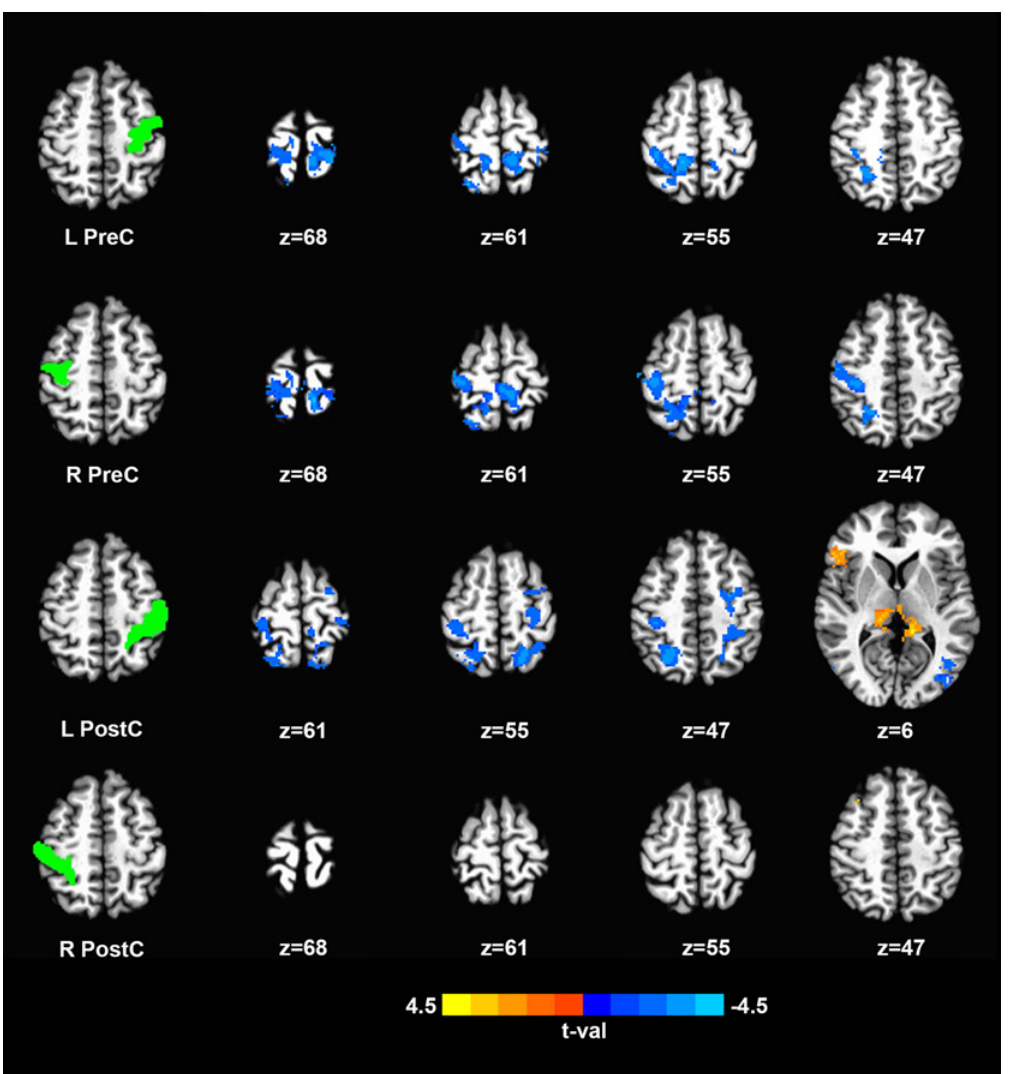
Fig 2. Changes in resting-state functional connectivity of sensorimotor network between SCI patients and controls with each row corresponding to a specific ROI. Left column, Location of ROIs. Remaining columns, Clusters showing significant difference in functional connectivity. Color-coded statistical t-value maps (corrected p < 0.05) showing positive and negative correlation (coded in yellow to light blue). Blue colors signifying negative t-values indicating SCI patients have lower connectivity to corresponding ROI compared to controls and vice versa (z-coordinates of cross sections are reported in Talairach space). SCI, spinal cord injury; ROI, region of